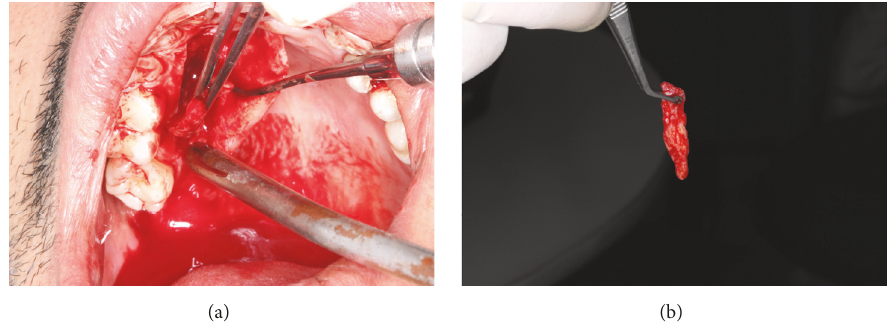
Figure 5: (a) Demarcation of the graft area on the donor site. (b) Removal of the subepithelial connective tissue.